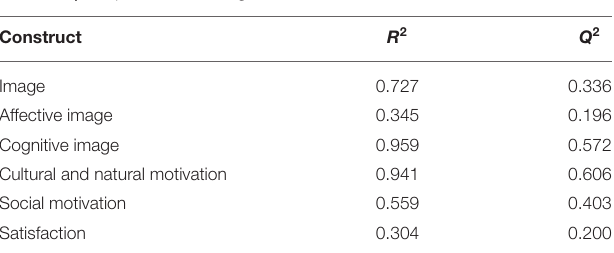
TABLE 8 | R square and